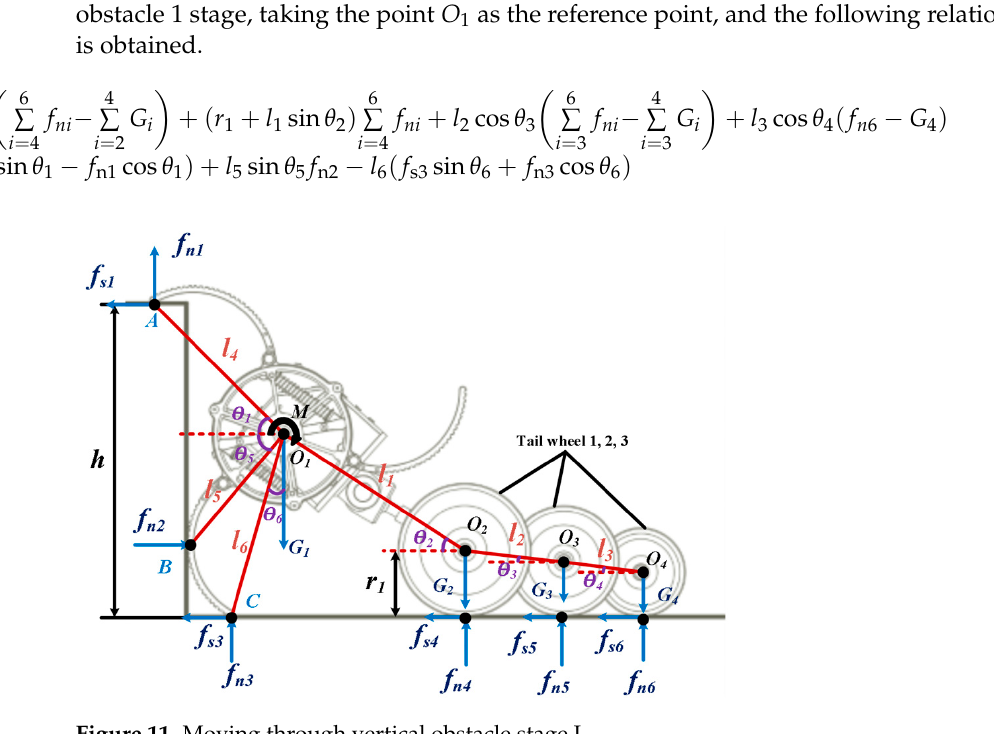
Table 1. Parameters and meaning of each parameter in the process of crossing the obstacle. Symbol Meaning The length between the center of the transformed wheel and the center of l i ( i = 1, 2, 3) the tail wheel 1, the center of the tail wheel 1 and the center of the tail wheel 2, and the center of the tail wheel 2 and the center of the tail wheel 3. The length between the trigger leg and the contact points A , B , and C . The radius of tail wheels 1, 2, and 3 Vertical obstacle height The angle between the line segment l i ( i = 1, 2, 3, 4) and the horizontal direction of the ground The acute angle between contact B and the center of rotation of the transformed wheel in the horizontal direction The acute angle between point C and the line connecting the center of the transformed wheel in the vertical direction